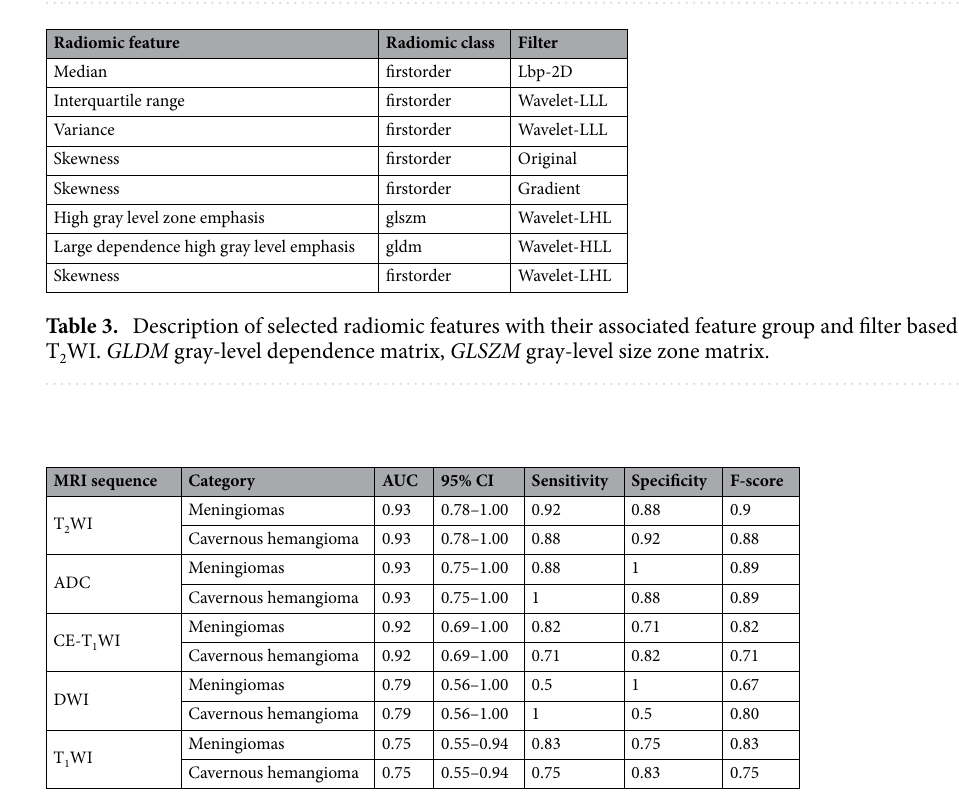
Table 4. Performance of KNN classifier radiomics models in differentiating parasellar cavernous hemangiomas from meningiomas in the validation set. MRI magnetic resonance imaging, T 1 WI T 1 -weighted images, T 2 WI T 2 -weighted images, DWI diffusion-weighted images, CE-T 1 WI contrast-enhanced T 1 -weighted images, AUC areas under the ROC curves, 95% CI 95% confidence